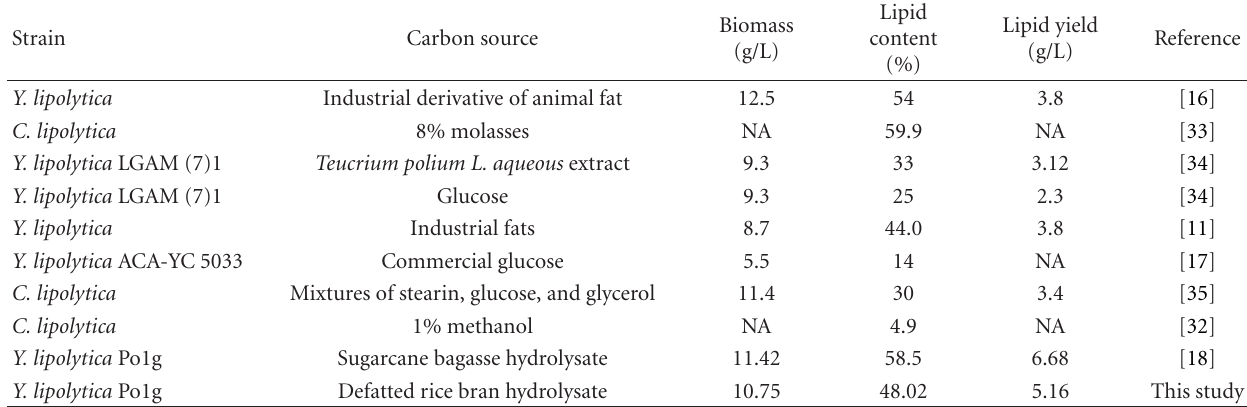
Table 4: Lipid contents of di ff erent strains of Y. lipolytica grown in di ff erent agroindustrial sources. Strain Carbon